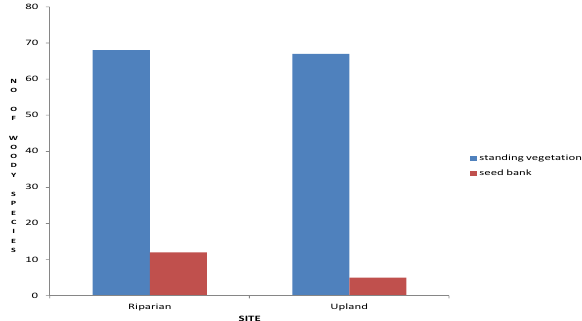
Fig. 6. Monthly emergence of seedlings and species at both depths from the rainy season in Upland vegetation